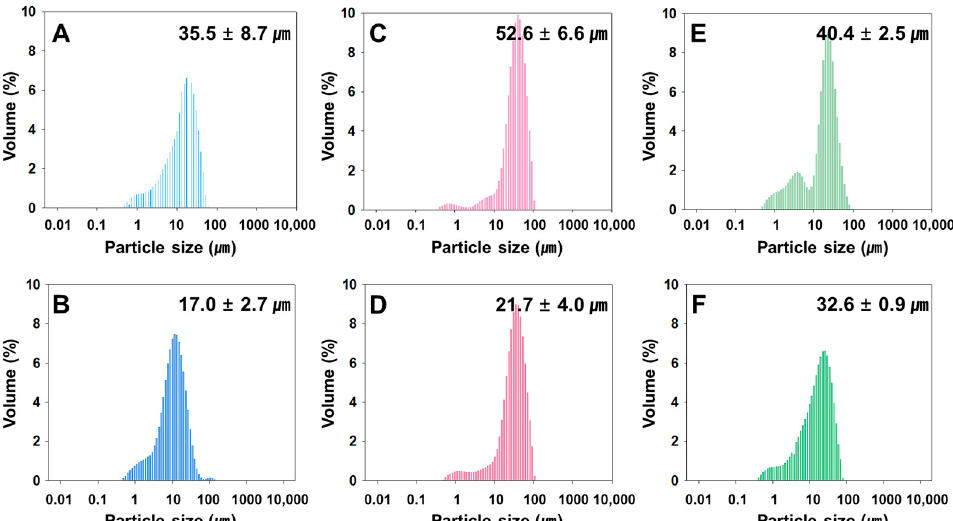
Figure 2. Size distribution of rivoceranib microspheres, determined by a light scattering method. ( A , B ) microspheres were fabricated using PLGA RG502, ( C , D ) microspheres were from PLGA RG502H, ( E , F ) microspheres were from PLGA RG503H. Microspheres ( A , C , E ) were prepared at the emulsifying speed of 1500 rpm. Microspheres ( B , D , F ) were prepared at 2000 rpm.